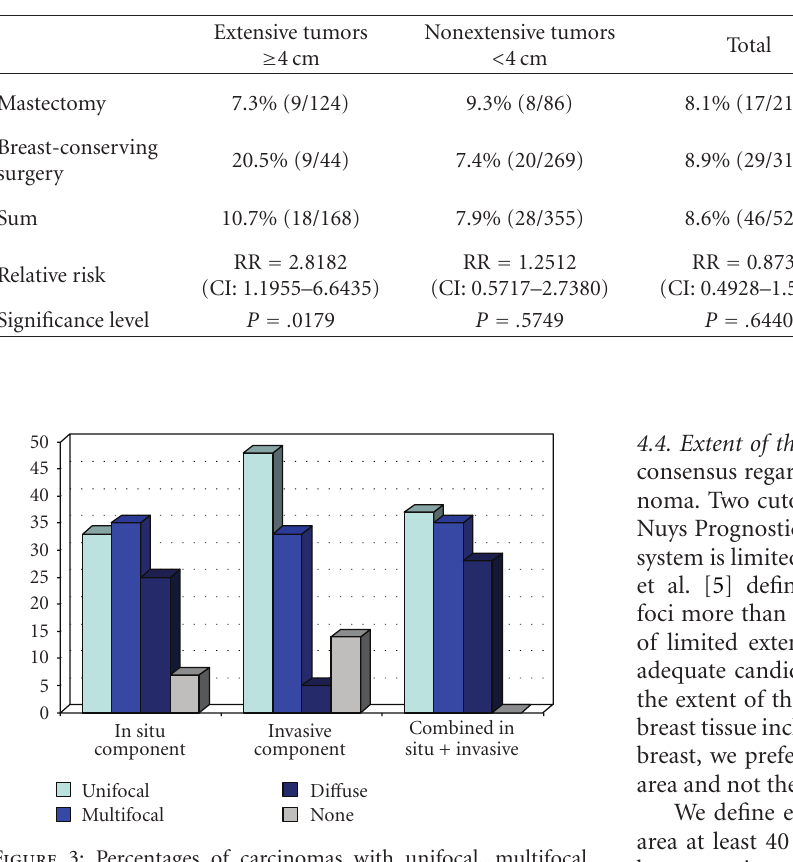
Table 1: Ipsilateral local recurrence rates by disease extent and type of surgery: extensive tumors defined as those occupying an area 4cm or larger in the greatest dimension. Falun 1996–1998, 10-year followup.